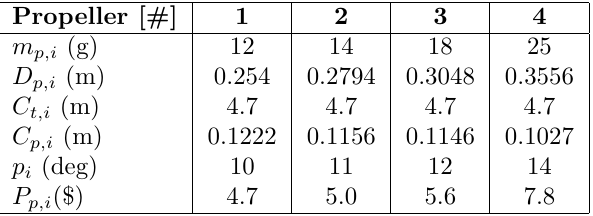
Table 7: Datasheets: Propellers. m p,i is the weight of the propeller, p i is the pitch angle of the blade and P p,i is the propeller